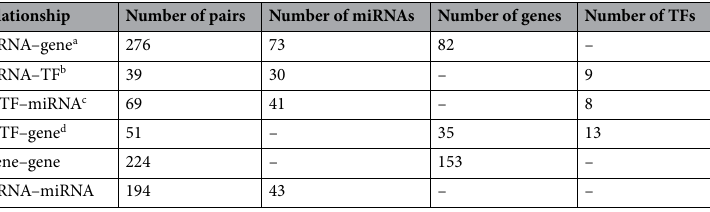
Table 2. Summary of six types of regulatory relationships among MG-related miRNAs, genes, and TFs. MG myasthenia gravis, miRNA microRNA, TF transcription factor. a miRNA represses the gene